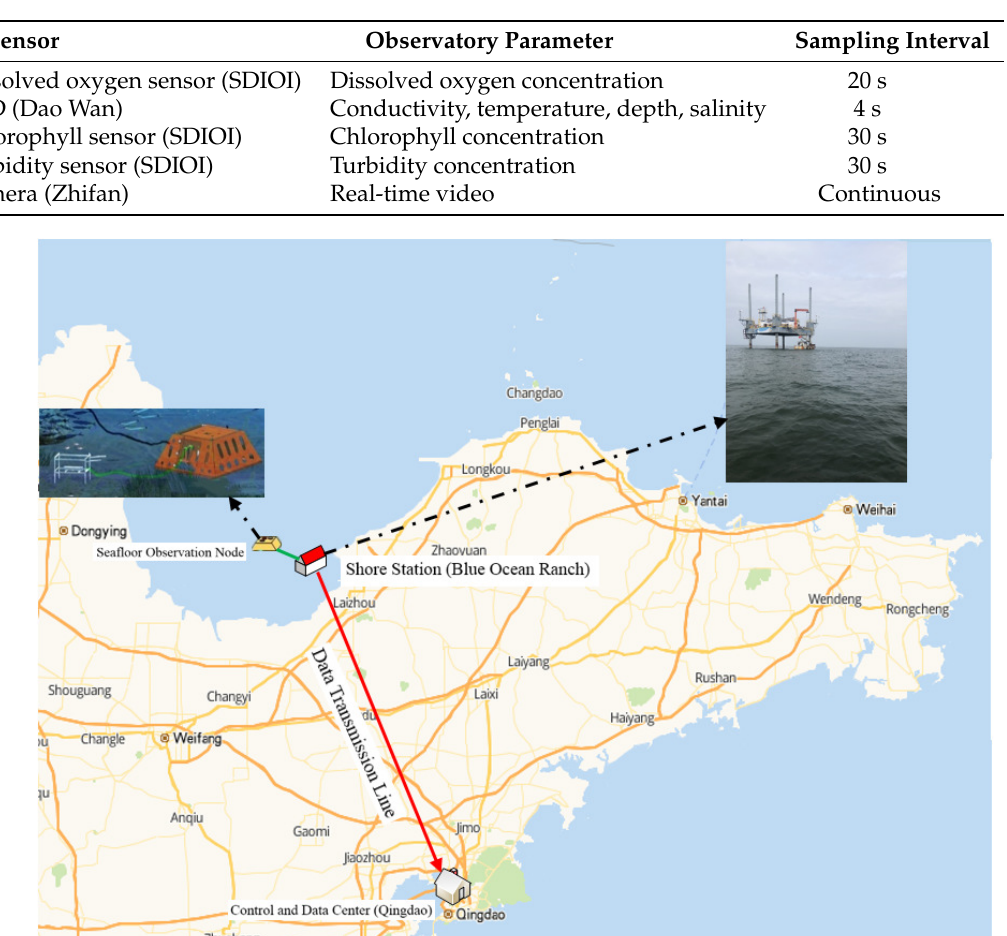
Table 3. The underwater devices connected to the seafloor observatory network.